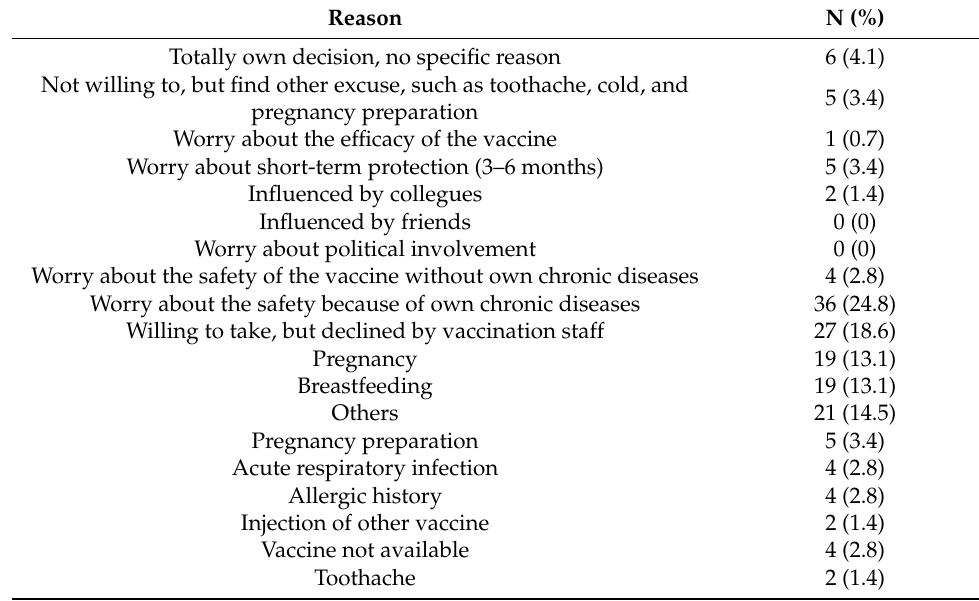
Table 5. Reasons for decline of COVID-19 vaccination in 145 unvaccinated